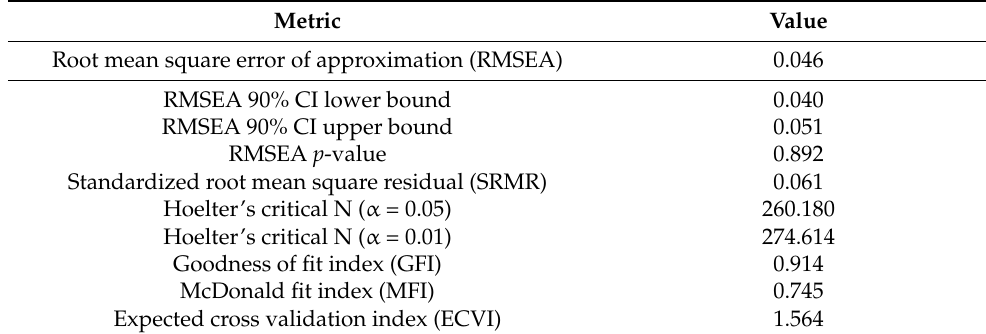
Table 4. Other fit measures.